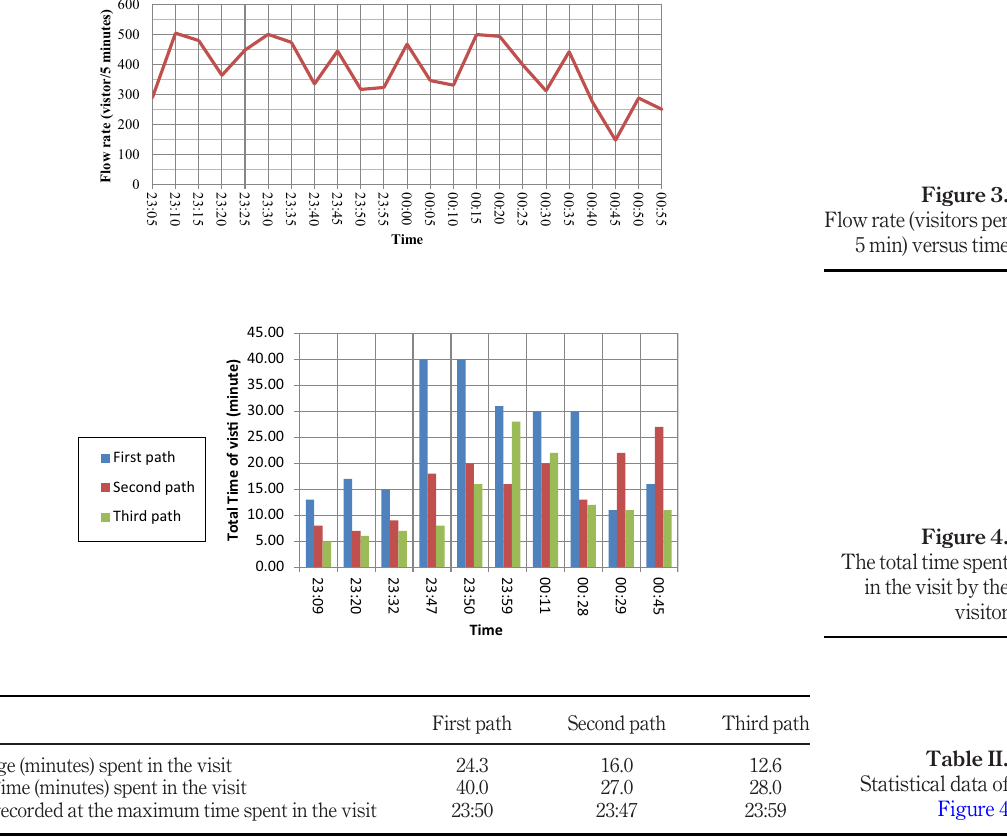
Figure 4. The total time spent